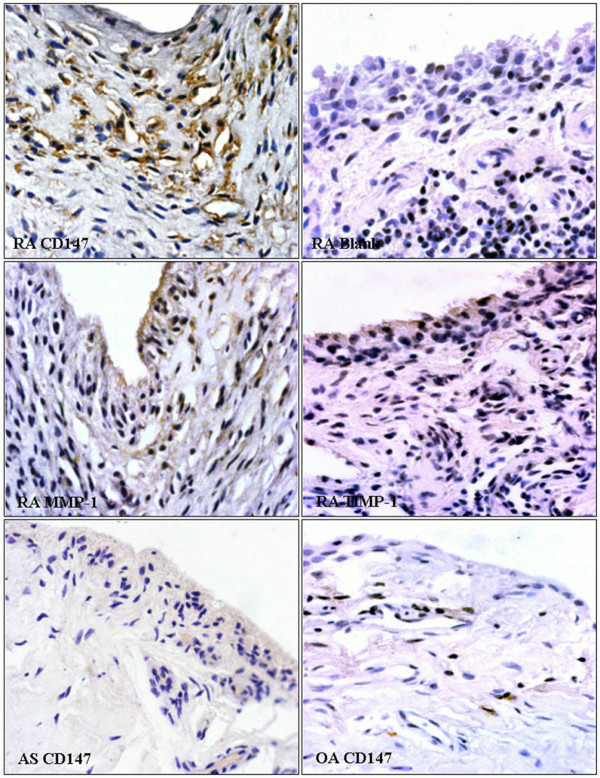
Immunohistochemistry staining of synovium. The top four images show the expression of CD147 (RA CD147), matrix metalloproteinase-1 (RA MMP-1), tissue inhibitor of metalloproteinases-1 (RA TIMP-1) and blank contrast (RA blank) in the lining and sublining layers in RA synovium (× 400). The bottom two images show the expression of CD147 in ankylosing spondylitis (AS CD147) and osteoarthritis (OA CD147) synovium. CD147 was predominantly expressed by macrophage-like cells and fibroblast-like synovial cells in the lining layer and partly by endothelial cells in the rheumatoid arthritis (RA) synovium. The primary antibody used for the blank contrast for streptavidin/peroxides staining was PBS (× 400).